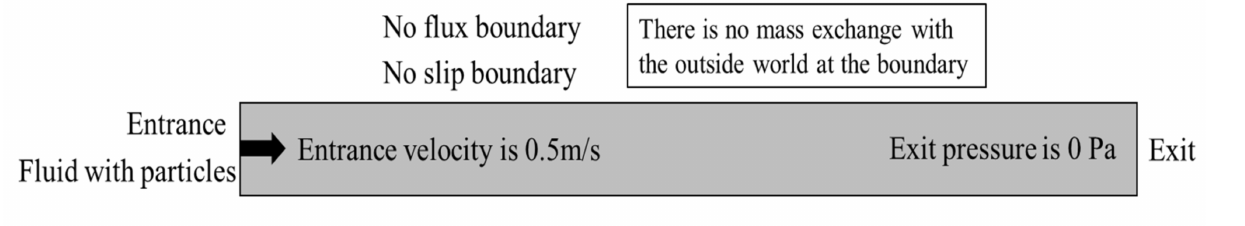
Figure 15. The boundary conditions of the model.